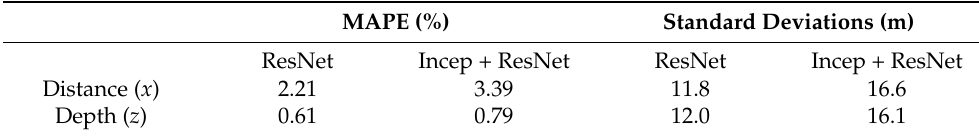
Table 3. A summary of the statistical analysis of the uncertainty between the predictions and ground-truth values for the two deep CNNs implemented.